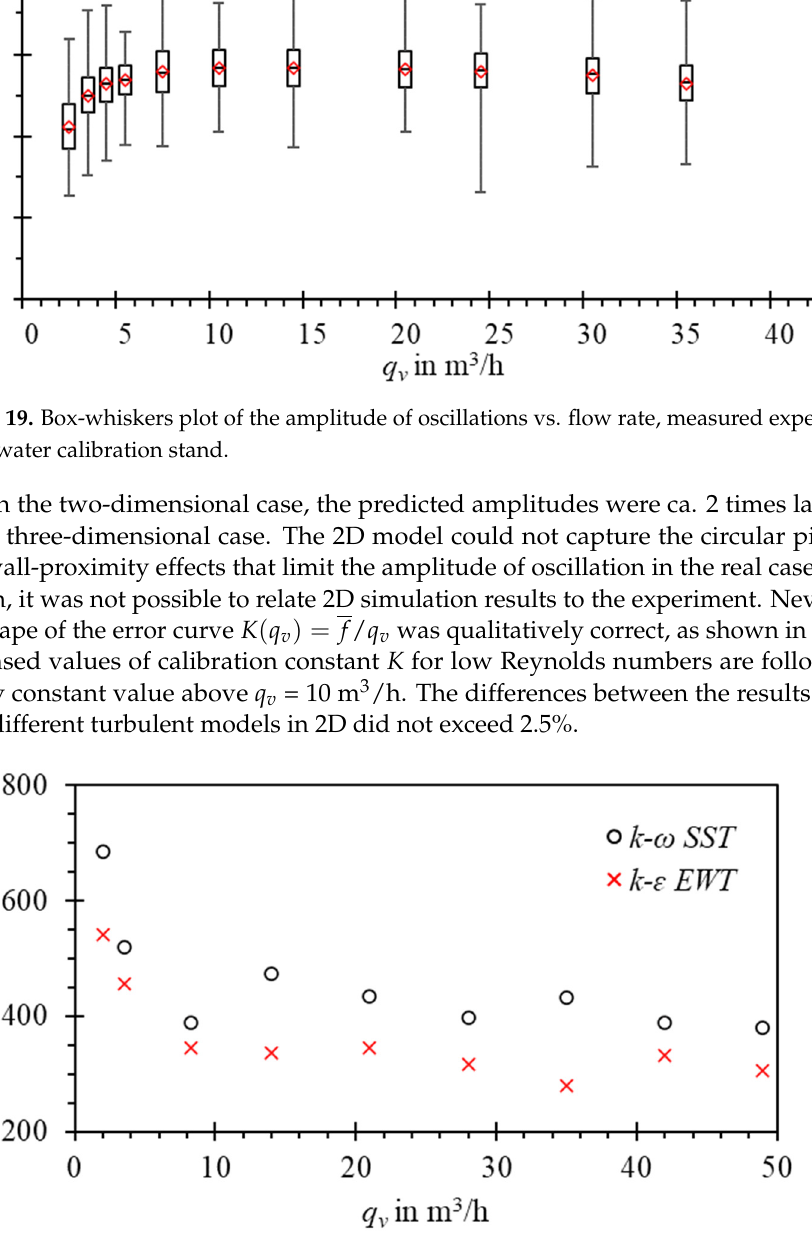
Figure 20. Error curve obtained with the two-dimensional model, overset method, G3 grid, and mean CFL < 1.